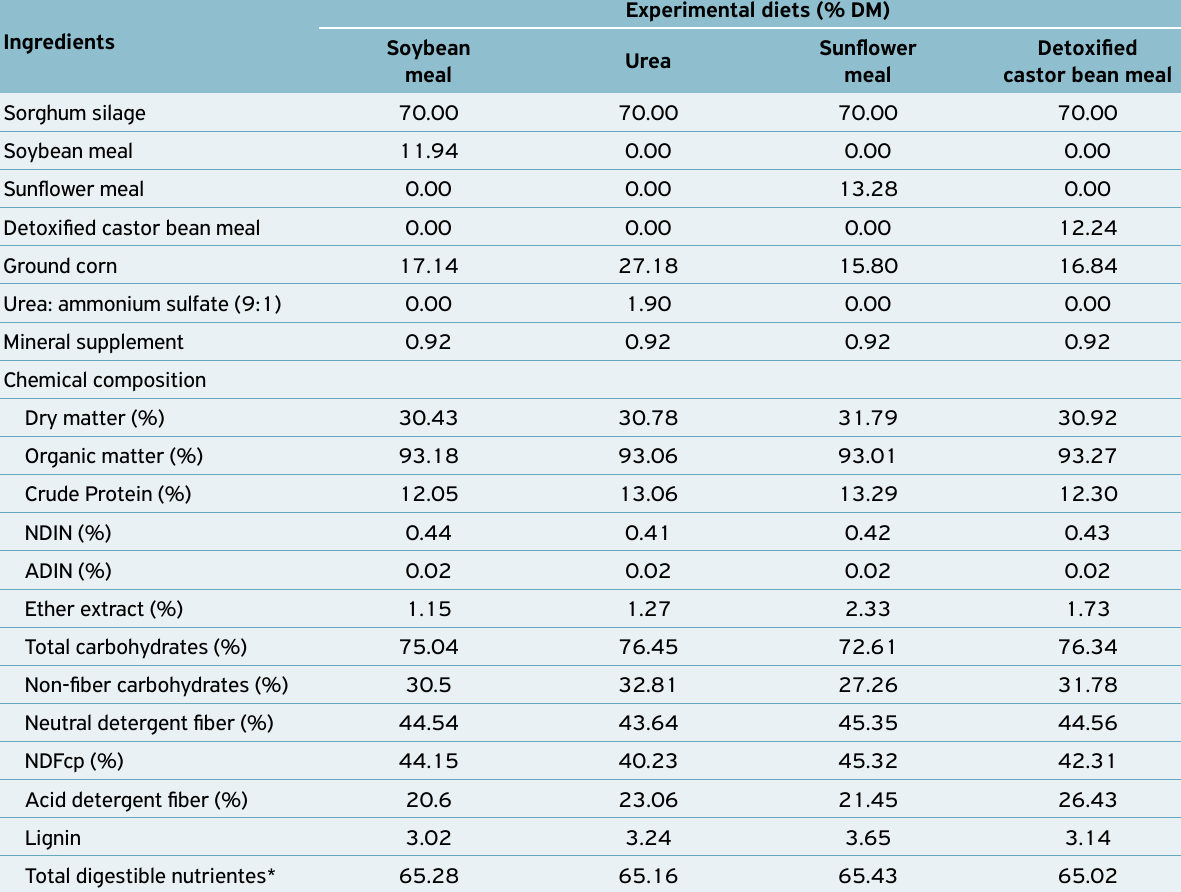
Table 1. Proportion of ingredients of the experimental diets (%) and chemical composition of the diets, on a dry matter basis